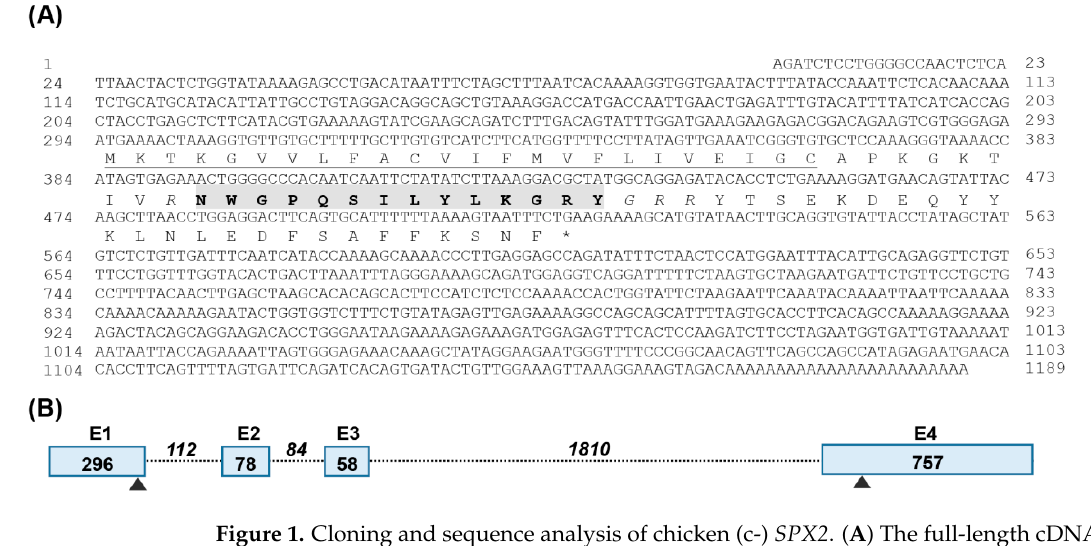
Figure 1. Cloning and sequence analysis of chicken (c-) SPX2 . ( A ) The full-length cDNA sequence and deduced amino acid of chicken Spexin2 ( cSPX2 ). The predicted signal peptide (24 amino acids) is underlined, and the mature peptide (14 amino acids) is shaded in gray, which is flanked by two dibasic cleavage sites noted by italic letters. ( B ) Exon (E)-intron organization of cSPX2 , the numbers indicate the sizes of exons or introns, and arrowheads represent the locations of start codon and stop codon.